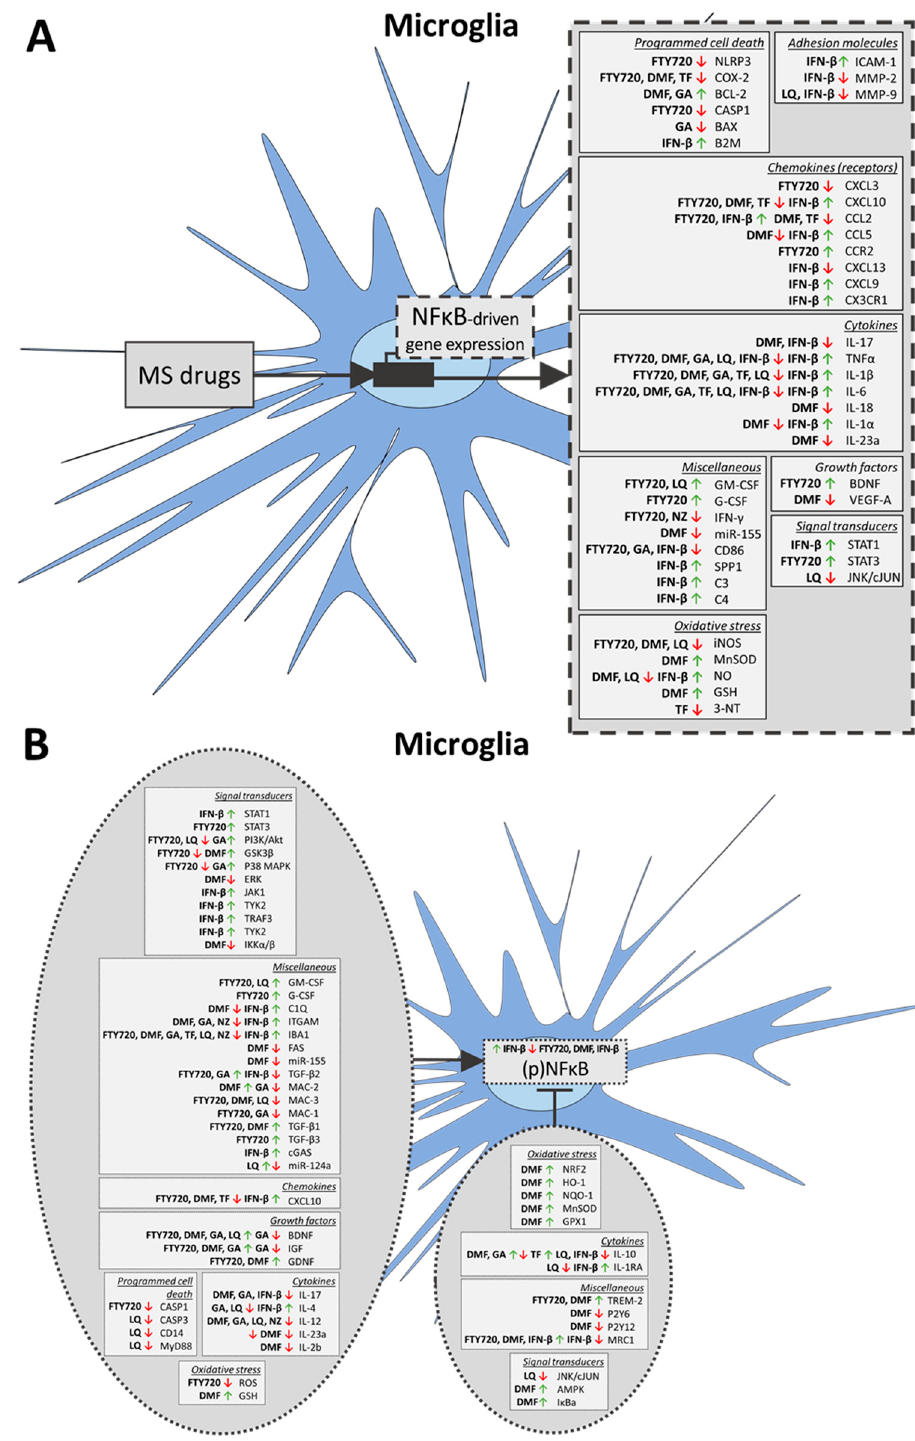
Figure 2. MS drugs directly or indirectly target NF κ B signaling in microglia. The effects of MS drugs on ( A ) NF κ B-driven gene expression and ( B ) the expression of genes known to affect NF κ B signaling are shown. Black arrows: stimulation; bar-headed lines: inhibition; red arrows: decreased expression; green arrows: increased expression. Genes mentioned in A within the rectangular frame are under transcriptional regulation of NF κ B. Genes mentioned in B within the circular frames are upstream regulators of NF κ B.